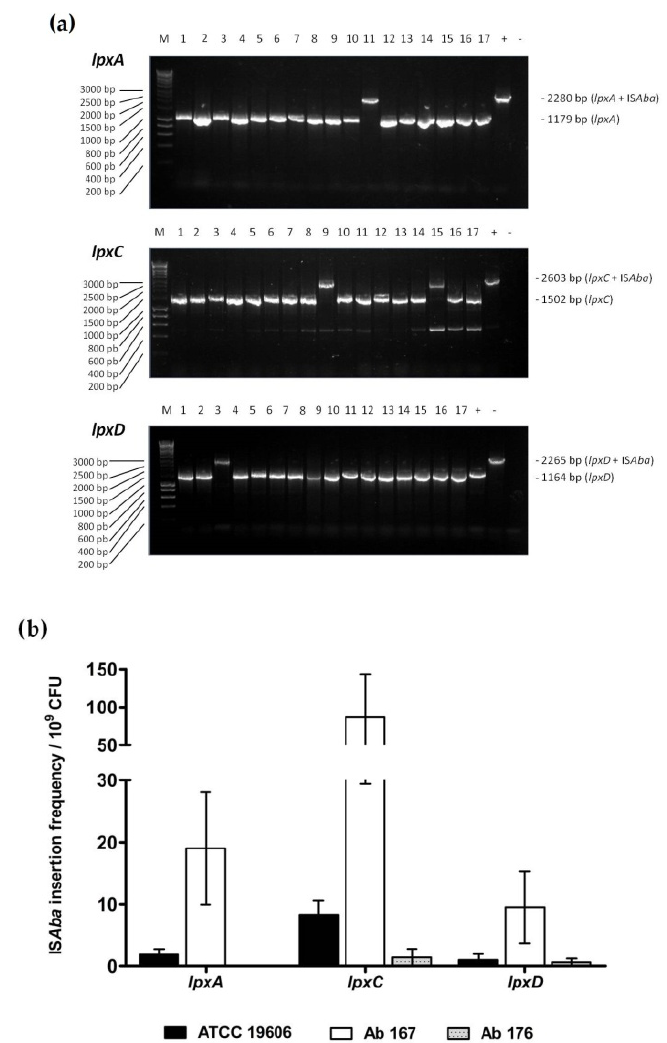
Figure 1. IS Aba insertion frequencies in lpxA , lpxC and lpxD genes in three A. baumannii strains. ( a ) Representative agarose gels showing PCR products obtained after amplifying lpxA , lpxC , and lpxD genes in order to screen colistin-resistant A. baumannii mutants for the presence of IS Aba insertions using the newly developed method described in the Materials and Methods section. ( b ) IS Aba insertion rates in lpxA , lpxC and lpxD genes in the A. baumannii strains ATCC 19606, Ab-167 and Ab-176 determined using the method described in the Materials and Methods section. M, DNA marker; +, positive control with a sequence-confirmed IS Aba 11 insertion; − , negative control; bp, base pairs.